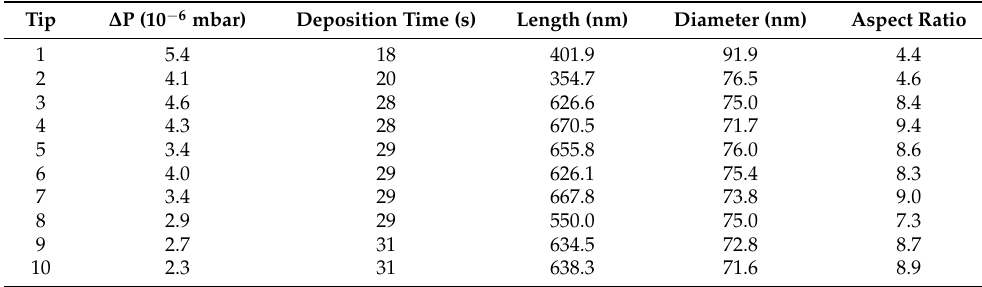
Figure 2. SEM images of FEBID Fe-based magnetic probes grown on the apex of commercial Aki- yama probes: ( a ) tip 5, ( b ) tip 7, ( c ) tip 8, and ( d ) tip 10. The length and diameter of the tips were around 650 nm and 75 nm, respectively. Table 1. Main growth parameters and geometrical dimensions of the Fe tips grown by FEBID. Deposition time as a function of precursor pressure ( ∆ P) is shown, as well as diameter, lengths and aspect ratio obtained under each condition. Precursor pressure is calculated as the difference between pressure during growth and base